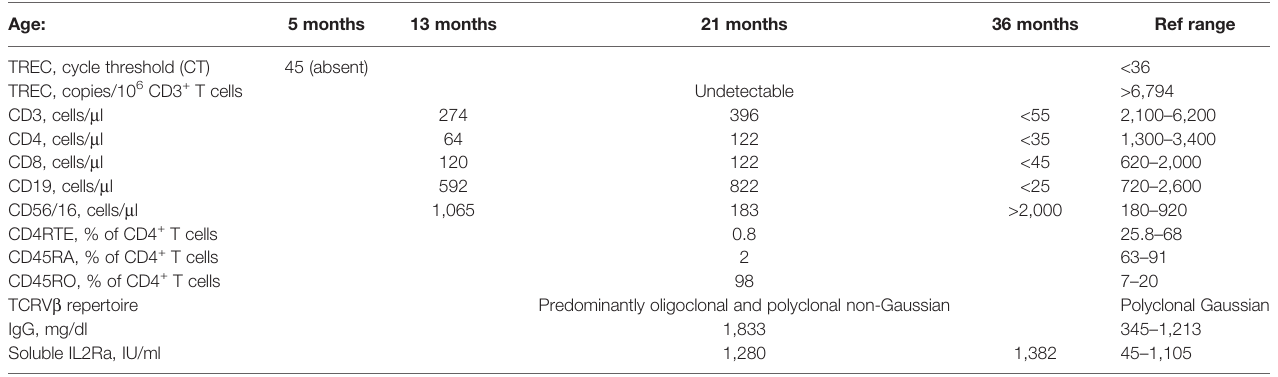
TABLE 1 | Immunologic evaluation of the patient between 5 and 36 months of age.